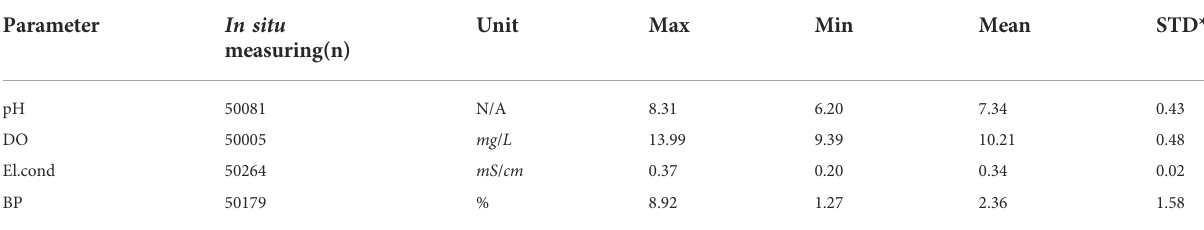
TABLE 1 Summary statistics of the BioFish